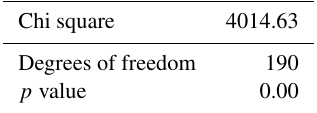
Table 1. Parametric and nonparametric statistical difference test among levels of social vulnerability.